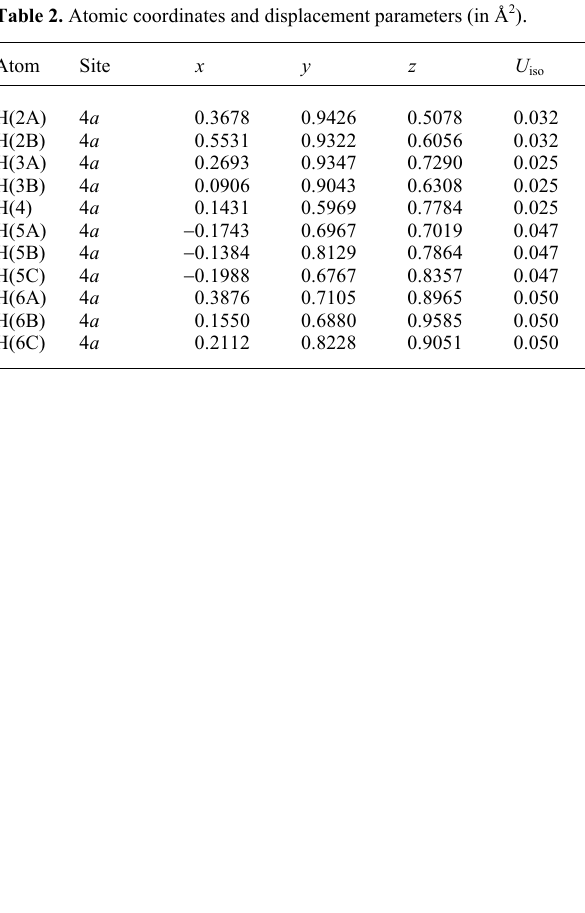
Table 1. Data collection and handling.